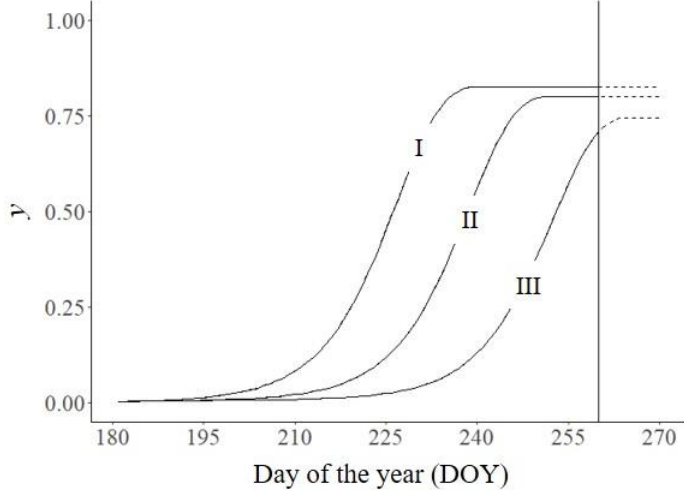
Figure 8. Effect on disease severity ( y ) of changing times when the disease epidemic begins. I: control, as in Figure 2 ( t 0 = 181, t e = 270); II: t 0 = 191, t e =270 (---) or 260 (—); III: t 0 =201, t e =270 (---) or 260 (—). A vertical solid line marks the advance of 10 days of harvest (i.e., t e = 260 instead of 270). Symbols are listed in Table 1.